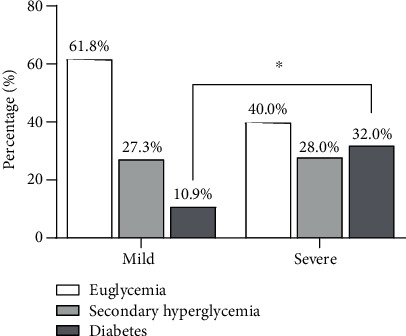
The corresponding proportions in each group. Mile cases: patients of the mild type and common type; severe cases: patients of the severe type and critical type.